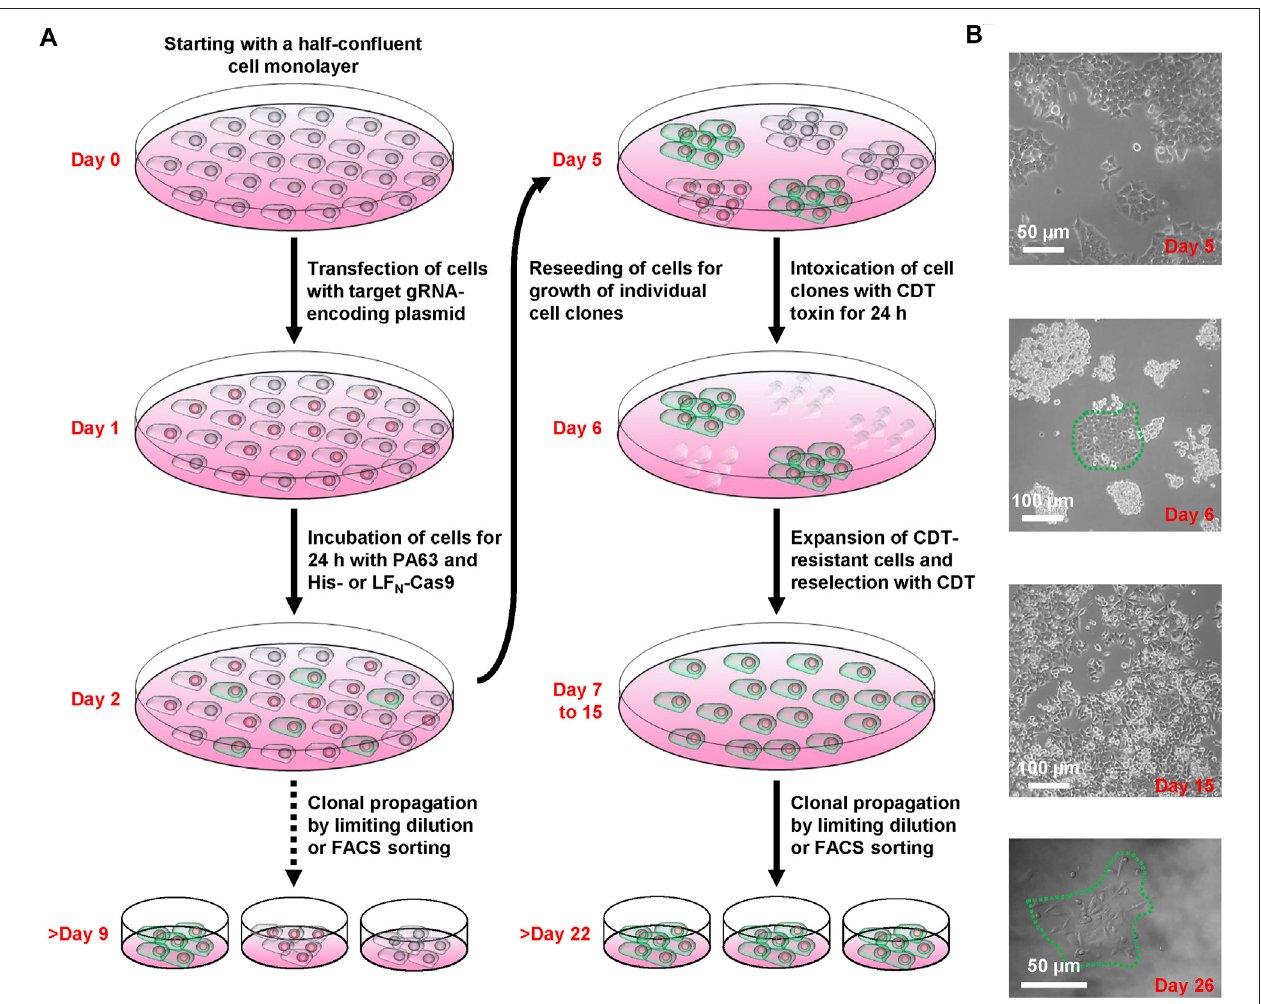
FIGURE2| WorkingschemeoftheCRISPAmutagenesisprotocol. (A) IllustrationofthesuccessivestepsoftheCRISPAapproachwithimagesofkeystepsshown in (B) .